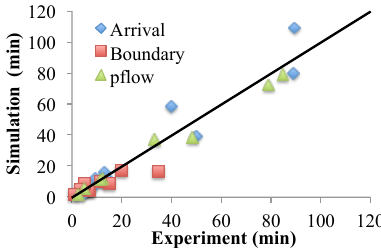
Figure 2. Timings of water arrival at the interface between layers (red squares), formation of a preferential flow path (green triangles), and arrival at the snow base (blue diamonds) for experiments and